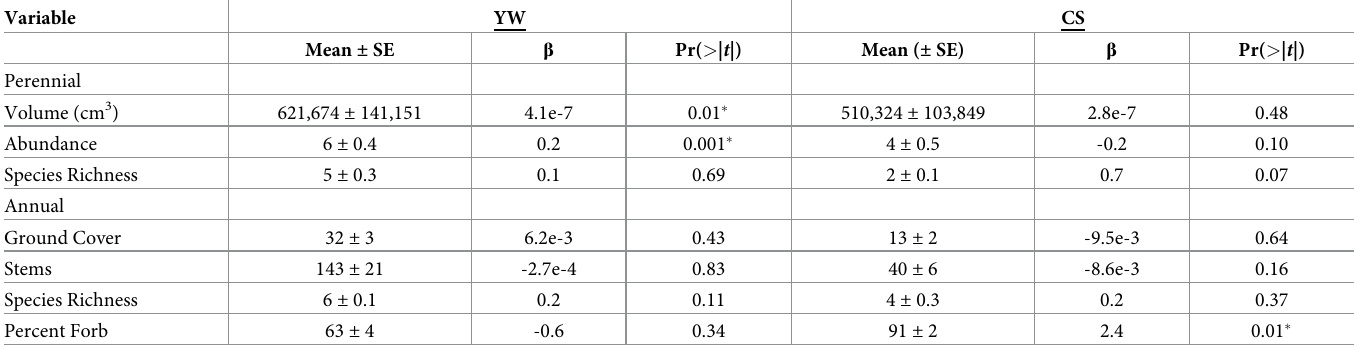
Table 2. Vegetation characteristics from female tortoise habitat around burrows occupied by females or paired points in August 2012 at Mojave National Preserve. Results of linear regression of habitat characteristics on selected versus available habitat in yucca woodland (YW) and creosote scrub (CS). Means are of habitat variables measured near occupied burrows. Significance indicated by ‘ �